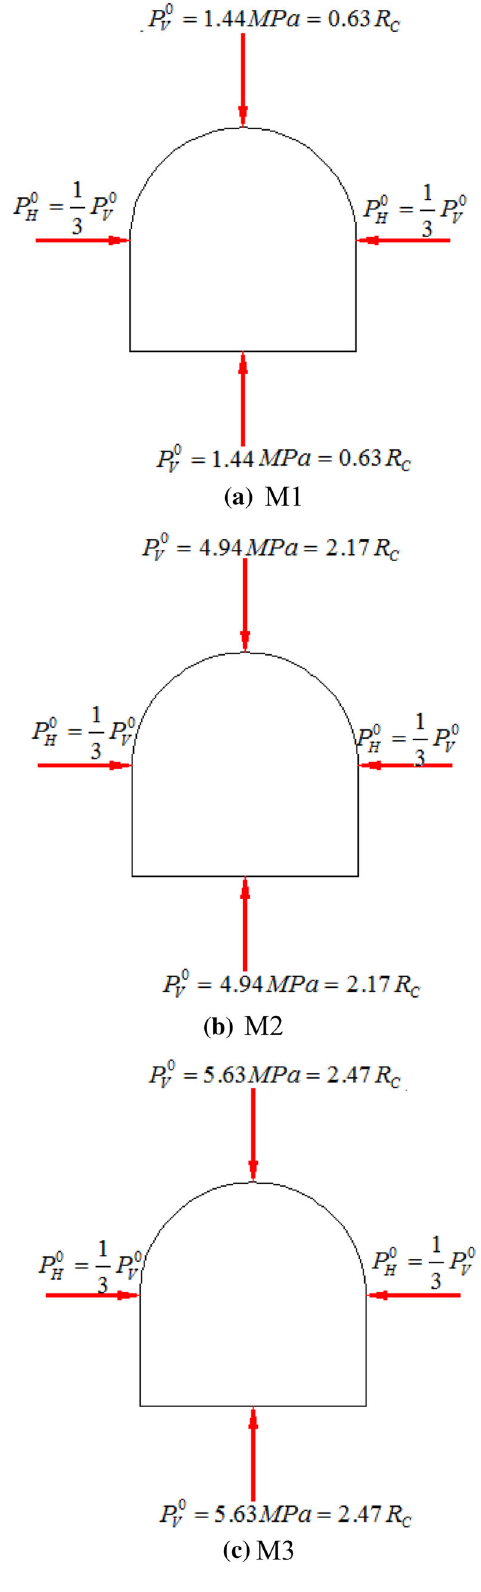
Fig. 5 Macroscopic fracture forms for the a M1 and b M2